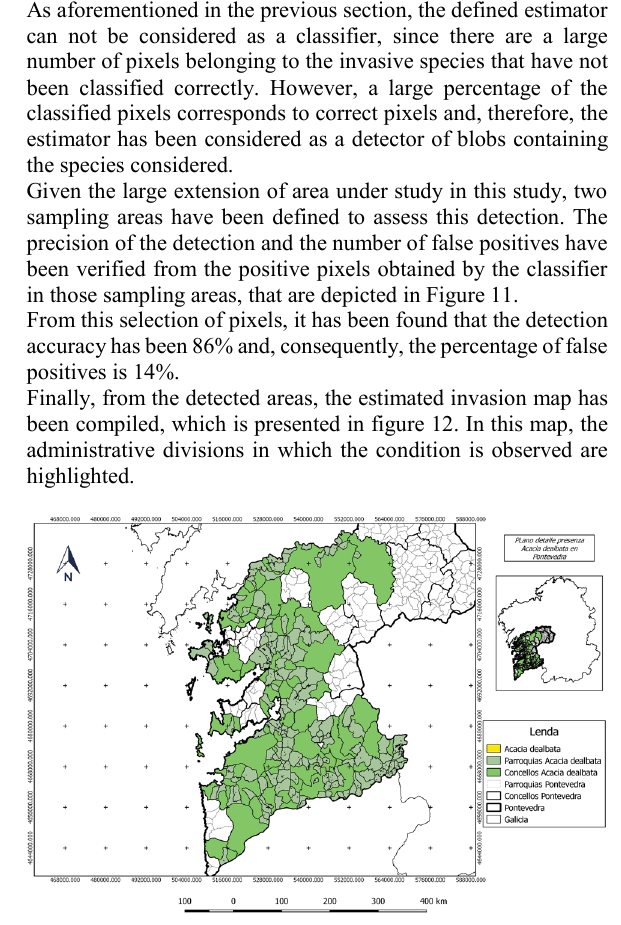
Figure 12 Acacia sp. map obtained. The Municipalities with positive detections of alien species are highlighted in